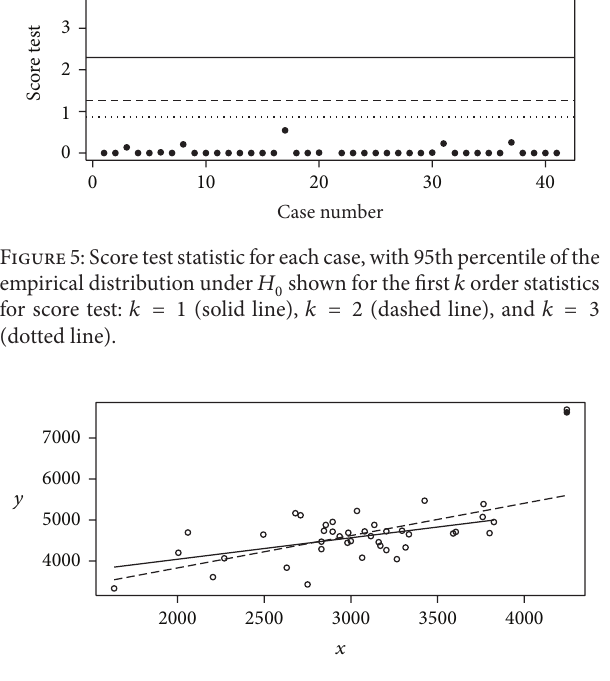
Figure 6: Concrete compressive strengths, in pounds per square inch, at 2 and 28 days, measurement error model (dashed line); a variance shift model (solid